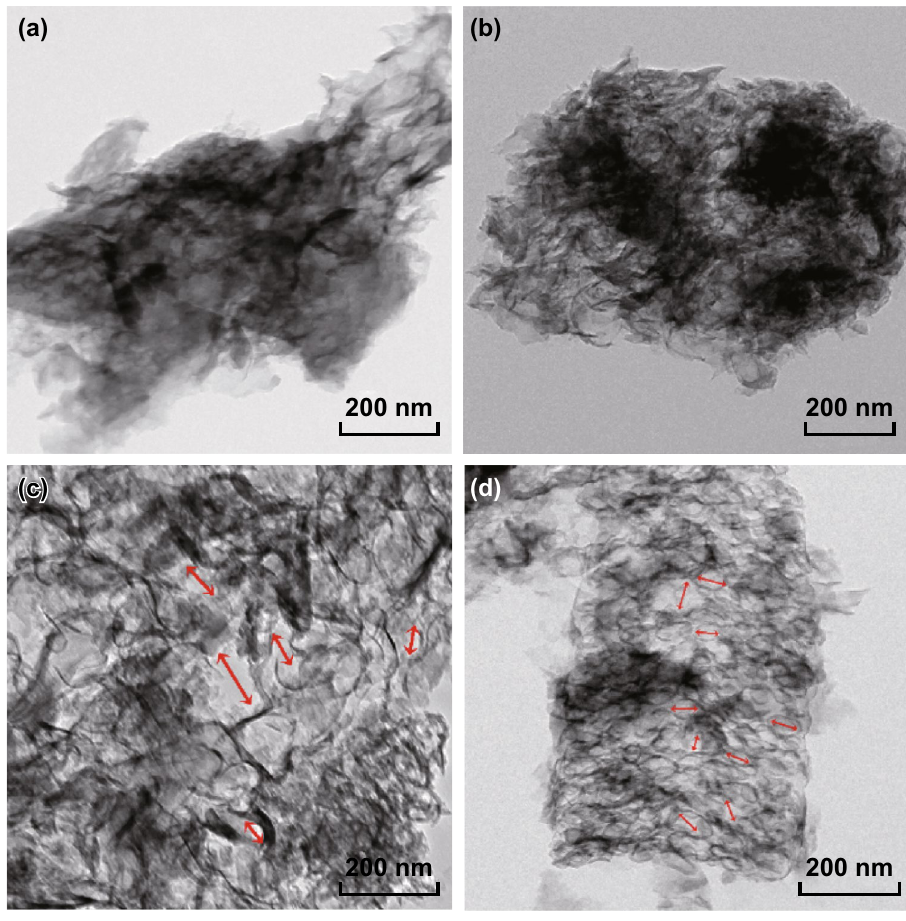
Fig. 3 TEM images of a, b P-CN and c, d